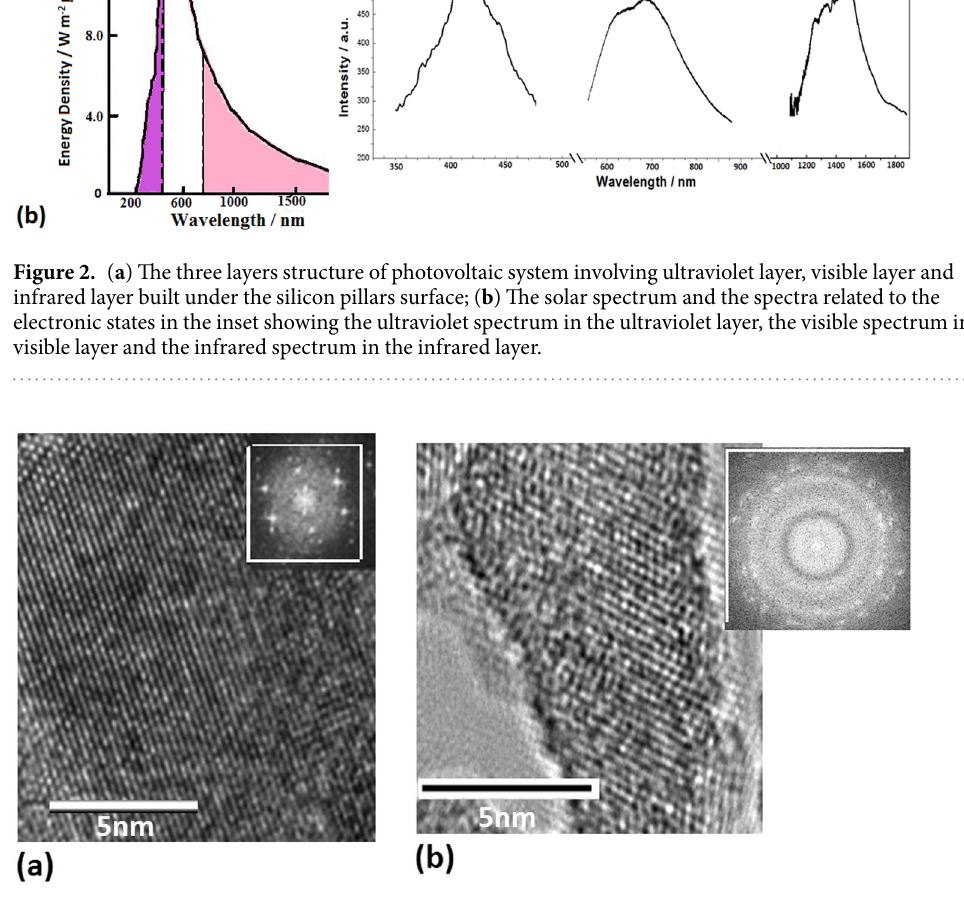
Figure 3. ( a ) TEM image of Si nanolayer prepared in vacuum, where the inset shows FFT pattern of silicon crystal after annealing for 30 min; ( b ) TEM image of Si nanolayer prepared in oxygen of 80 Pa, in which the FFT pattern of the inset exhibits the broken symmetry of silicon crystal doped with oxygen after annealing for 30